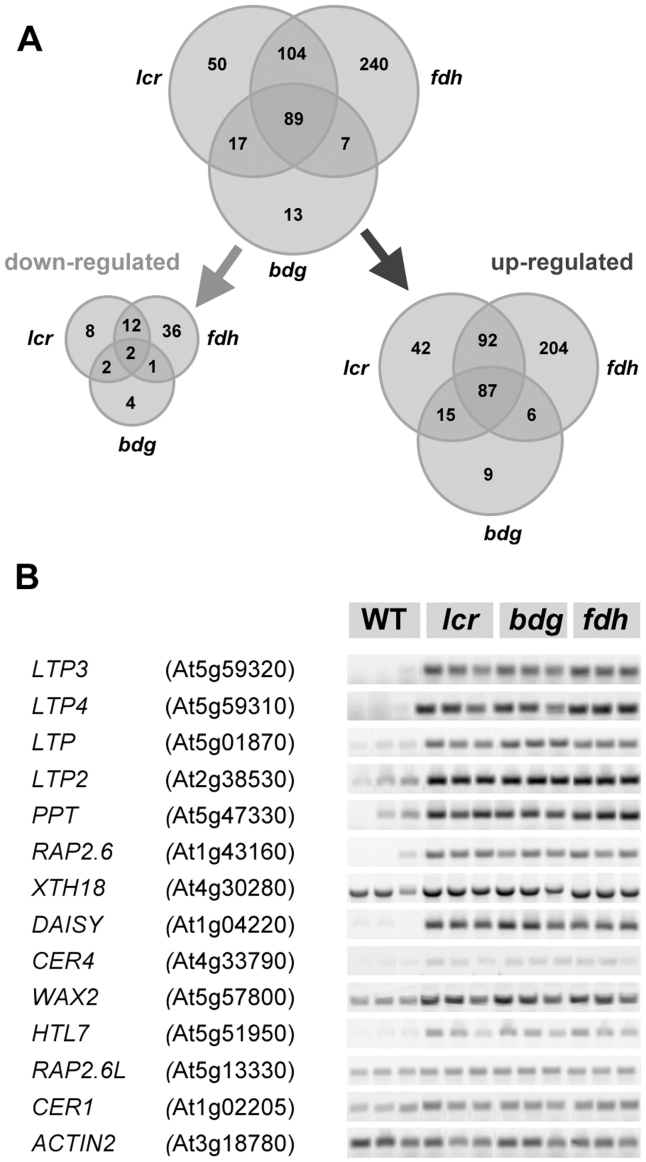
An overview of the microarray results in the three mutants.(A) Gene categories revealed by Rank Product statistical analysis, followed by a Venn diagram representing overlapping or non-overlapping gene sets. Differentially expressed genes were defined by pfp<0.05 (corresponds to FDR<0.05) between mutant and wild type samples. The set, which comprises 87 upregulated and 2 downregulated genes common to all three mutants, is detailed in Table S3. (B) Confirmation of the microarray data by semi-quantitative RT–PCR. Thirteen candidates were compared to ACTIN2 as a control. To allow the semi-quantitative estimation of differences, the number of PCR cycles has been optimized for each gene.